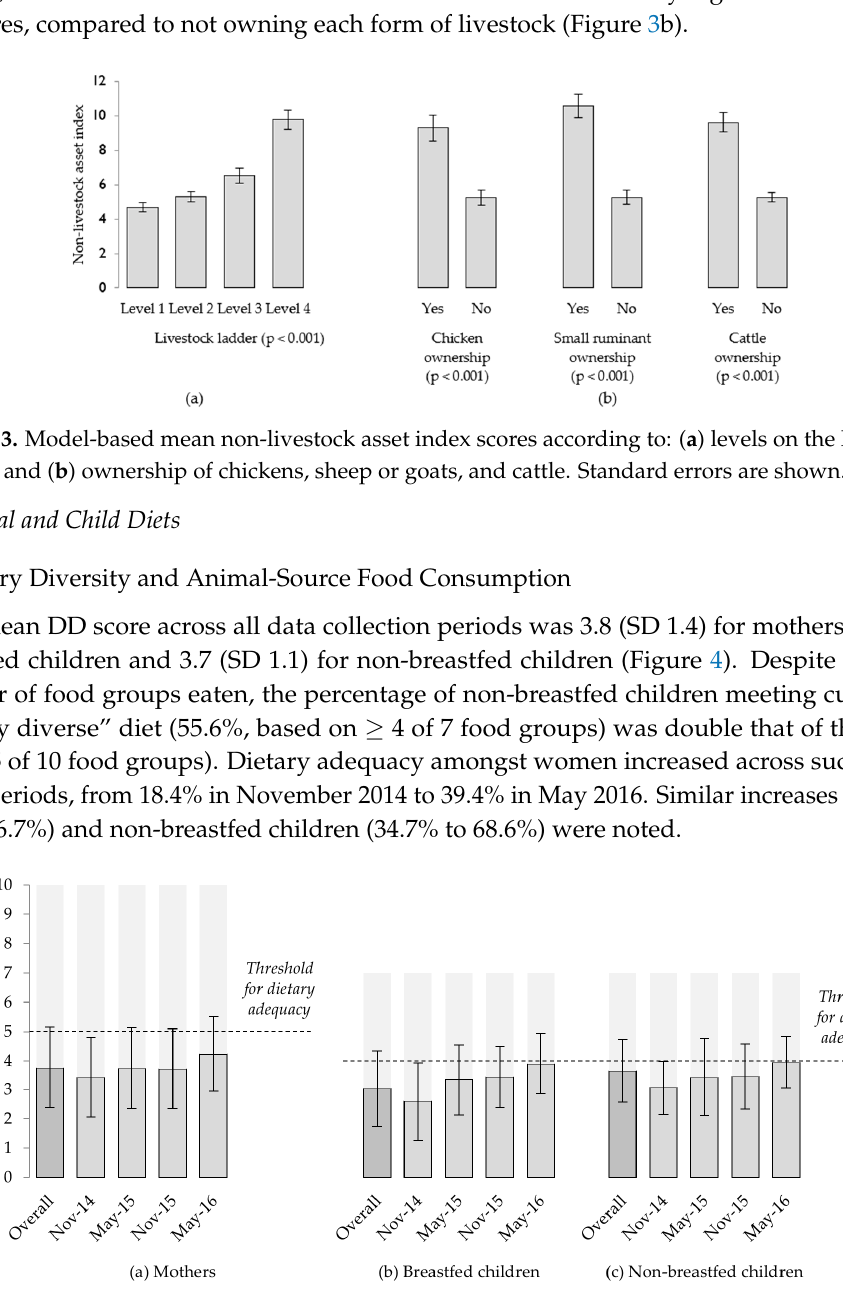
Figure 4. Mean dietary diversity scores of ( a ) mothers (using MDD-W indicator); and ( b ) breastfed and ( c ) non-breastfed children (both using IYCMDD indicator), overall and for each six-monthly data collection. Light grey shading indicates the number of food groups. Standard errors are shown.